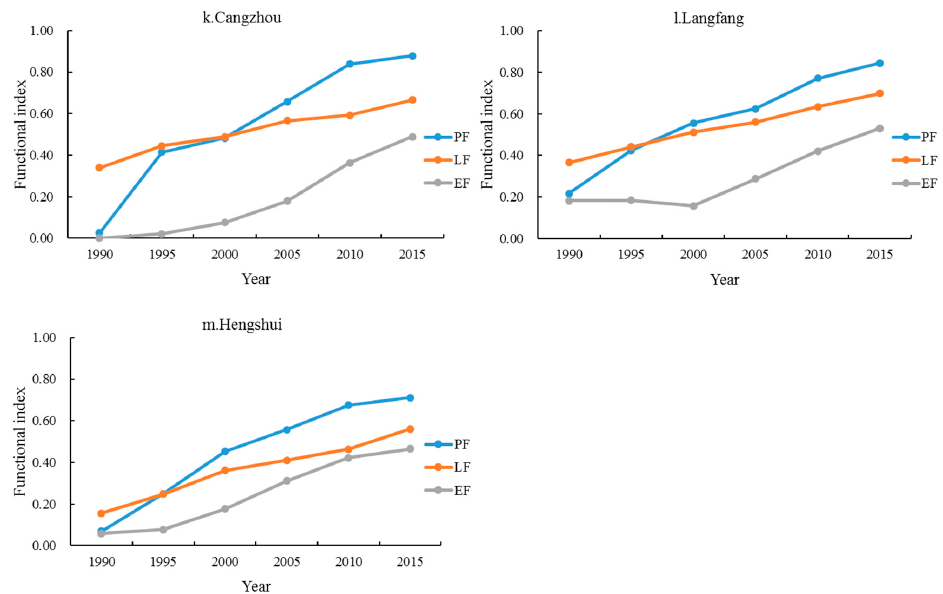
Figure 5. Changes in the production-living-ecology land use functions in the thirteen cities (1990–2015). ( a ) Beijing; ( b ) Tianjin; ( c ) Shijiazhuang; ( d ) Tangshan; ( e ) Qinhuangdao; ( f ) Handan; ( g ) Xingtai; ( h ) Baoding; ( i ) Zhangjiakou; ( j ) Chengde; ( k ) Cangzhou; ( l ) Langfang; ( m ) Hengshui.